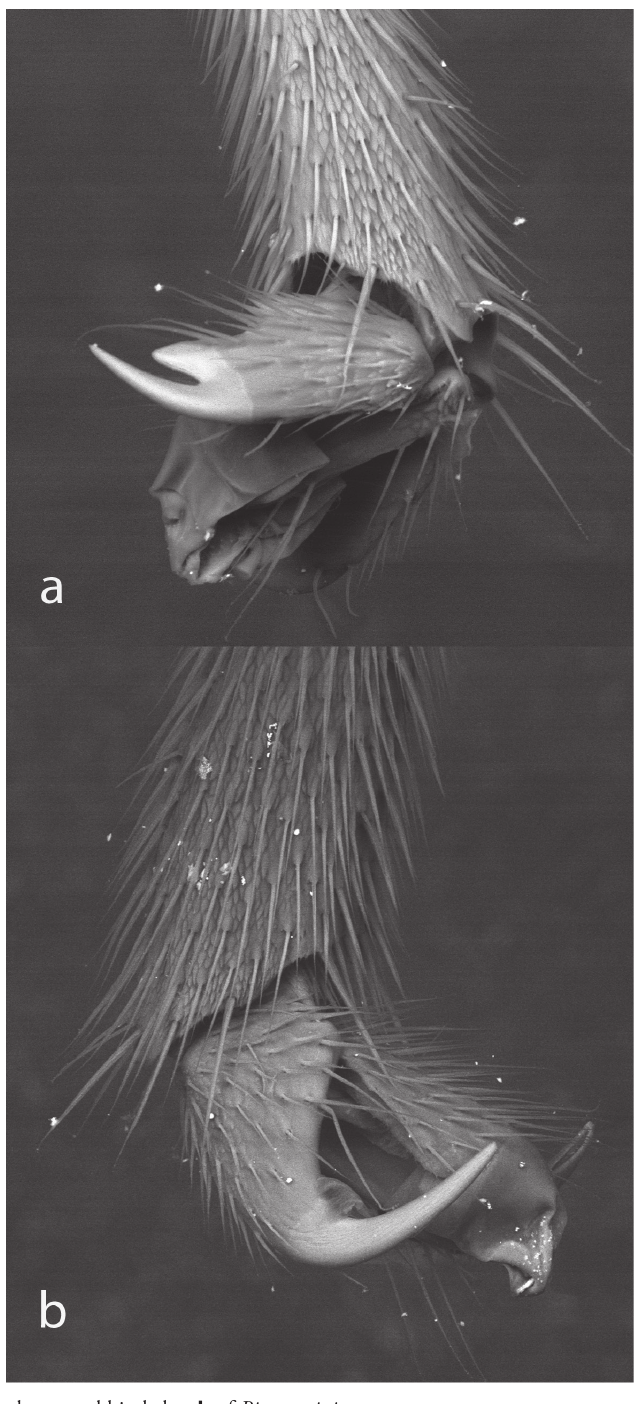
Figure 8. Fore claw a and hind claw b of Bicurta sinica